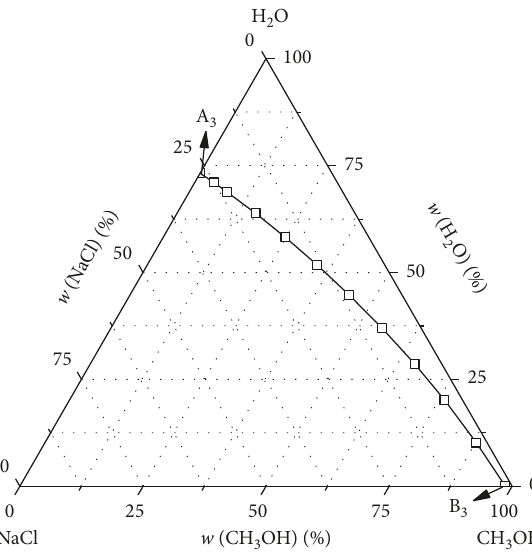
Figure 3: Phase diagram of the ternary system (NaCl + CH 3 OH + H 2 O) at